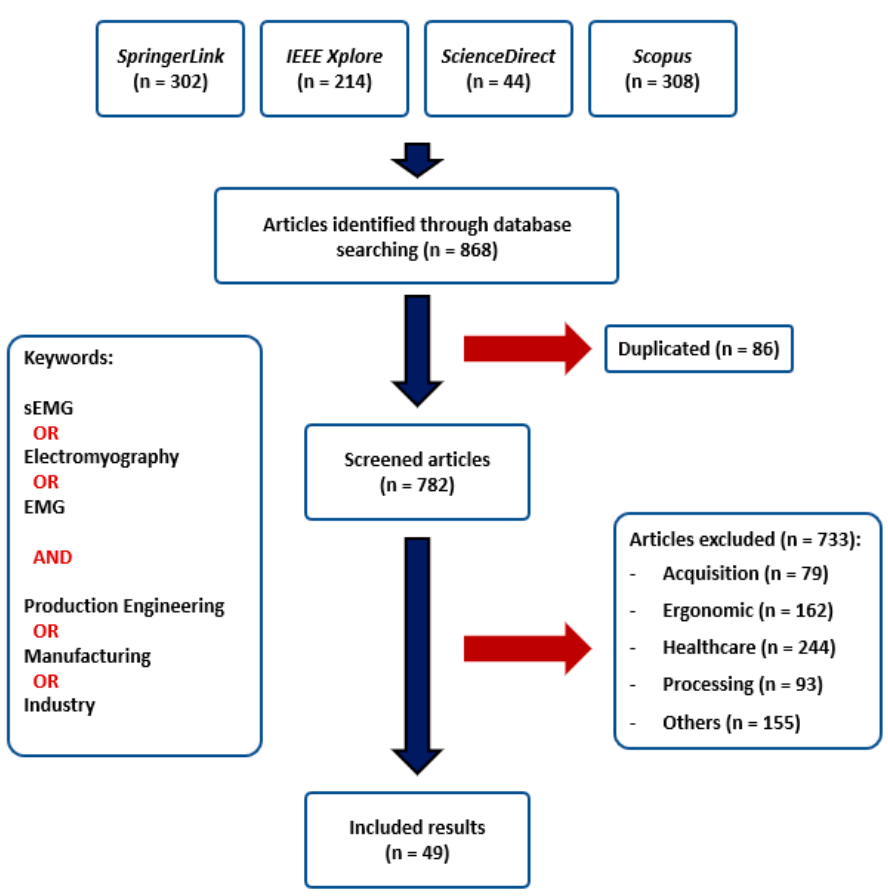
Figure 1. Flow-chart of article identification and screening.